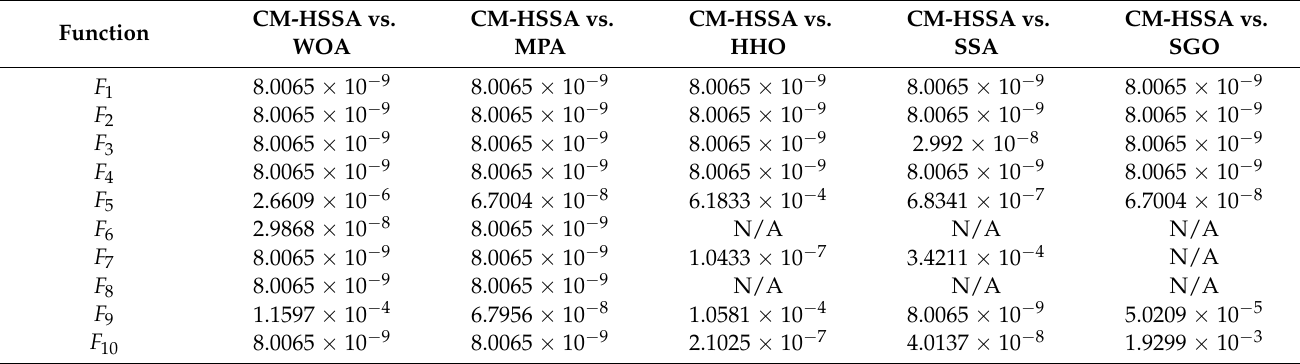
Table 3. The p -value test results over benchmark functions. CM-HSSA Function